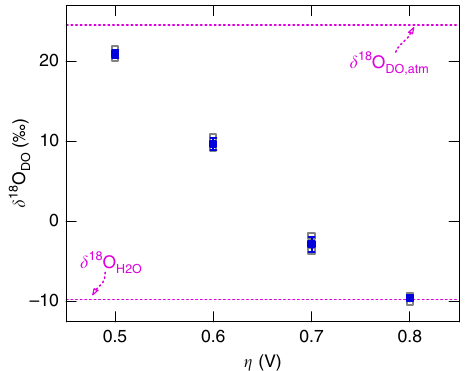
Fig. 2 Potential-dependent δ 18 O DO composition of O 2 evolved at nanoporous Fe 2 O 3 electrodes. The DO compositions are studied for O 2 evolving upon 3 h of steady-state electrolysis in a pH 7 aqueous KH 2 PO 4 electrolyte at different applied overpotentials 0.48 ≤ η ≤ 0.78V (potentials E vs. Ag/AgCl: + 1.10 ≤ E ≤ + 1.40 V). δ 18 O DO values are presented for three nominally identical individual samples (grey empty squares) and the corresponding average values with standard deviations (blue squares and bars). Isotopic compositions measured for atmospheric O 2 dissolved in the aqueous electrolyte and electrolyte H 2 O are given as control values (dashed lines): δ 18 O DO,atm = + 24.6 ‰ , δ 18 O H2O = − 9.8